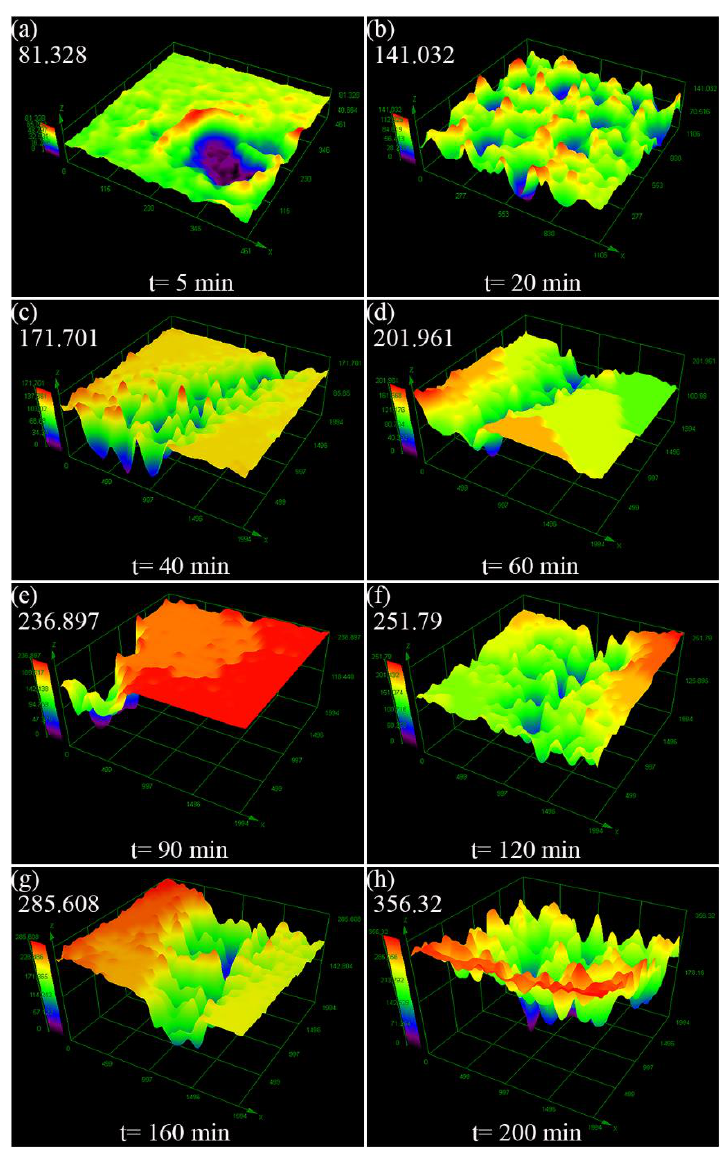
Figure 9. Three-dimensional morphology of Al surface after different cavitation erosion time in the distilled water ( a ) 5 min, ( b ) 20 min, ( c ) 40 min, ( d ) 60 min, ( e ) 90 min, ( f ) 120 min, ( g ) 160 min, ( h ) 200 min.